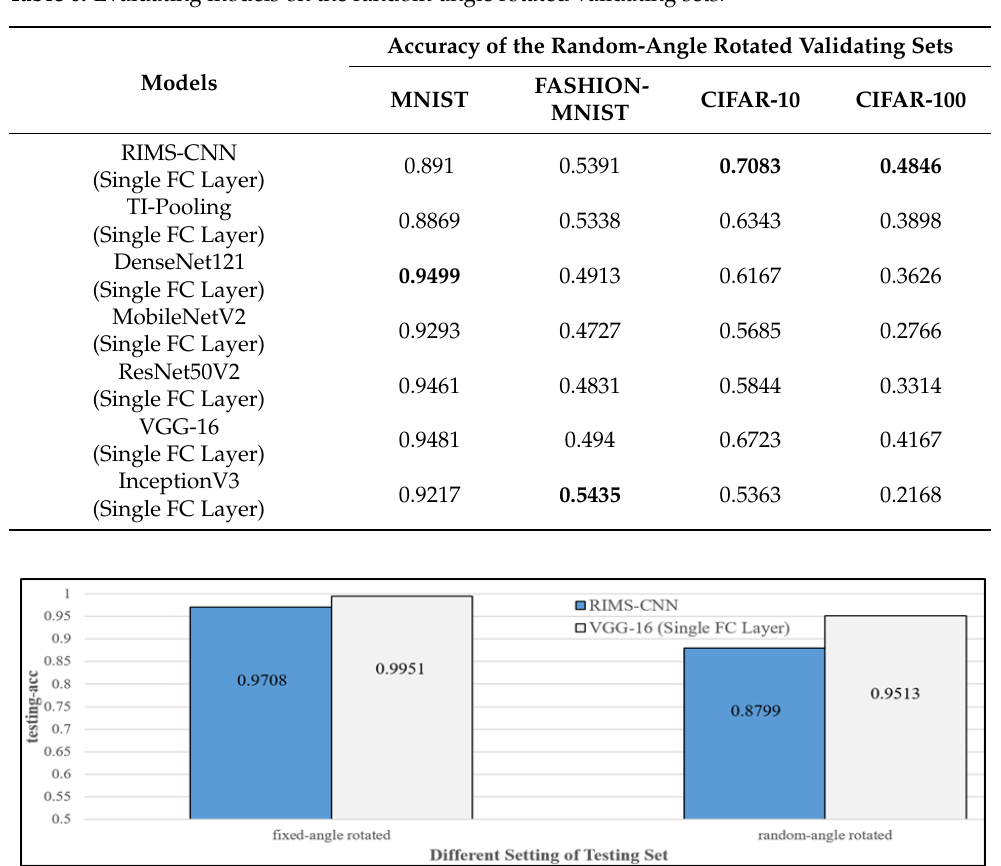
Table 6. Evaluating models on the random-angle rotated validating sets.